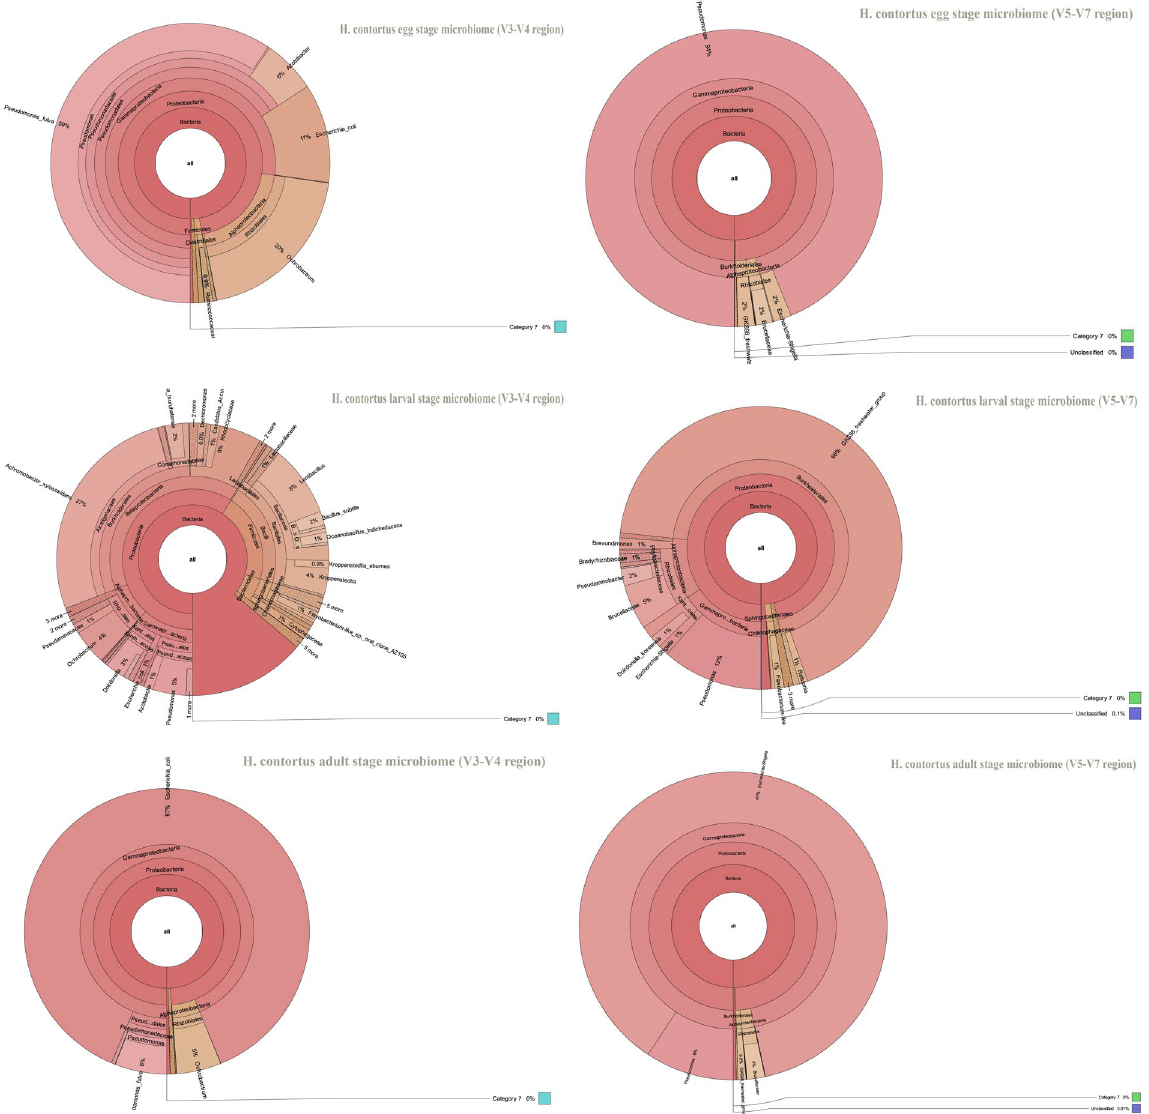
Figure 10. Krona plot of H. contortus egg-, larval-, adult- stage microbiome based on 16S rRNA gene sequence V3-V4 region ( A ) and V5-V7 region ( B ). Data represent average values from pooled populations (i.e. from each sheep) of eggs/larvae/adults (male and female) come from three different